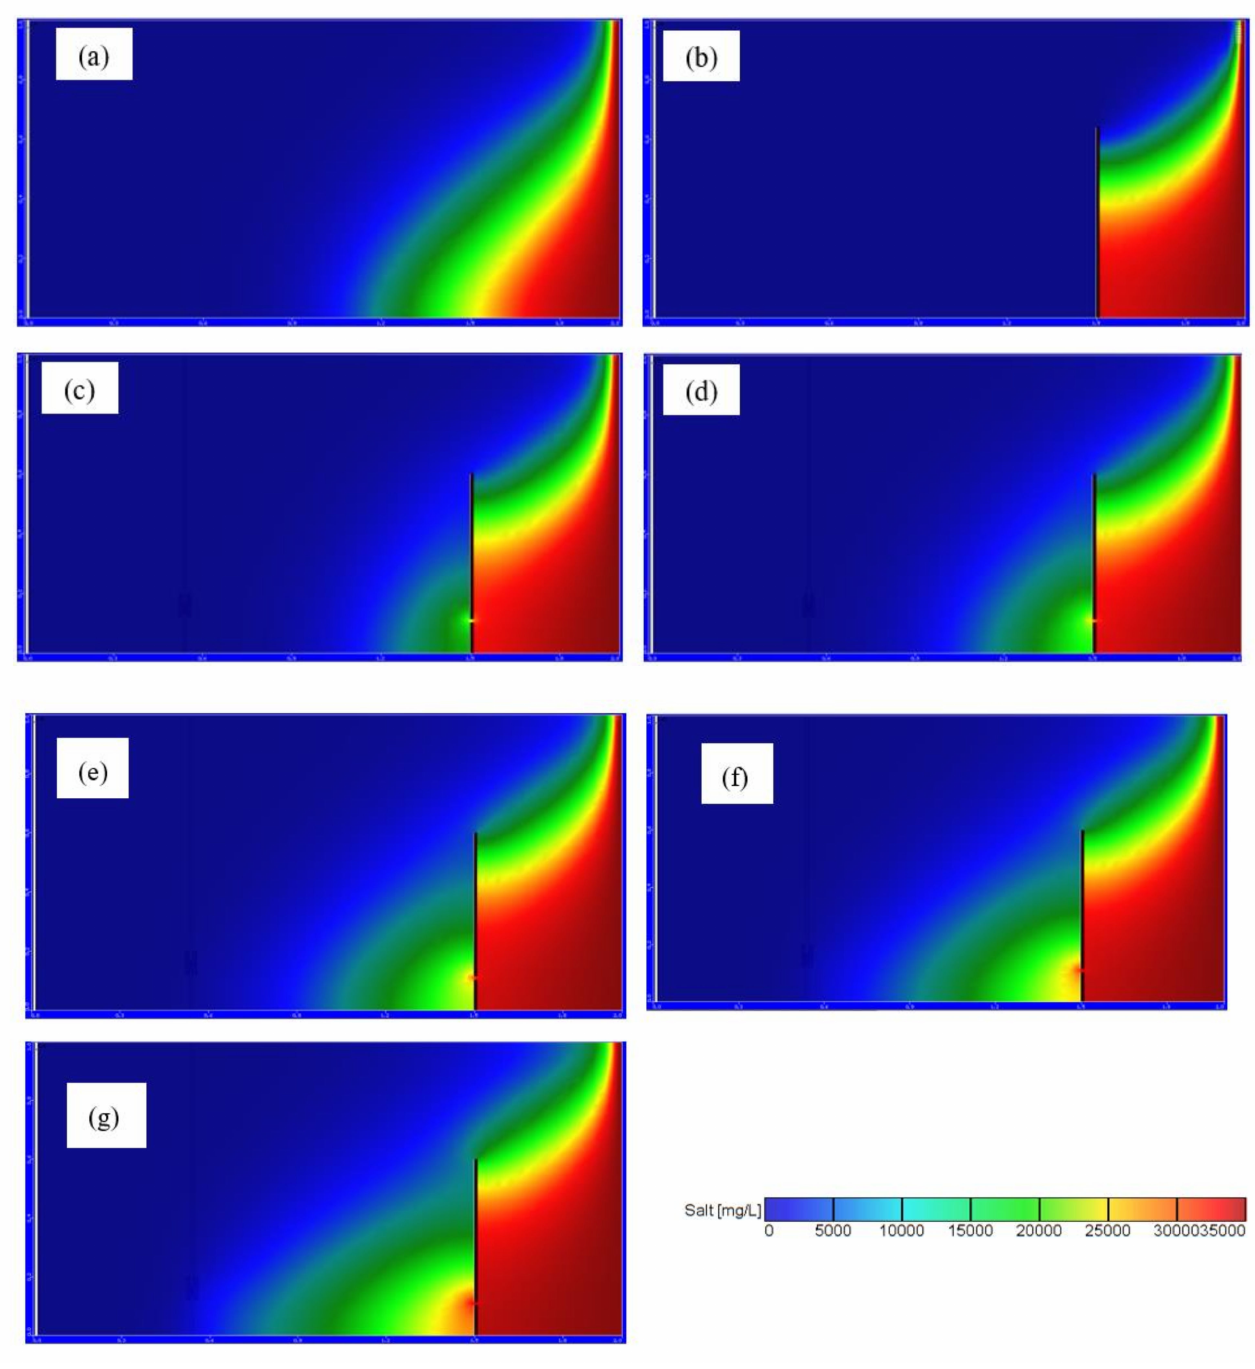
Figure 4. Steady-state saltwater intrusion for: ( a ) Henry base case; ( b ) subsurface dam at L d = 0.5 m with H d = 0.6 m; ( c ) D f = 0.005 m, H f = 0.1 m, Q w = 1 × 10 − 6 m 3 /s; ( d ) D f = 0.005 m, H f = 0.1 m, Q w = 2 × 10 − 6 m 3 /s; ( e ) D f = 0.005 m, H f = 0.1 m, Q w = 3 × 10 − 6 m 3 /s; ( f ) D f = 0.005 m, H f = 0.1 m, Q w = 4 × 10 − 6 m 3 /s; and ( g , d ) D f = 0.005 m, H f = 0.1 m, Q w = 5 × 10 − 6 m 3